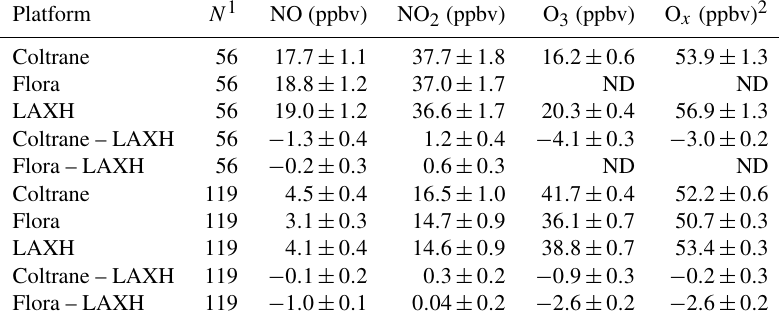
Table 10. Comparison of mobile-platform to collocated stationary-site measurements made at LAXH on 20 September 2016. The two cars alternated positions between an audit location at 6.6m, for Coltrane, and 8.5m, for Flora, horizontal distance from the ground-level coordinates of the LAXH monitor (inlet situated 4.2ma.g.l. inside a fenced enclosure) and a sampling location further from the monitor (24.1m for Coltrane and 18.5m for Flora). Data from the audit tests are excluded. The Coltrane audit period was 10:22–00:20PDT ( n = 119). The Flora audit period was 09:19–22:20PDT ( n = 56). The means ± standard errors of the means were determined for each car from the 1min measurements made at the two distances from the stationary monitor. Standard errors indicate the uncertainties of the mean concentrations and mean differences. Differences of 1min measurements were determined prior to averaging. The variabilities in the 1min differences can be obtained by multiplying standard errors by square root of sample size ( n